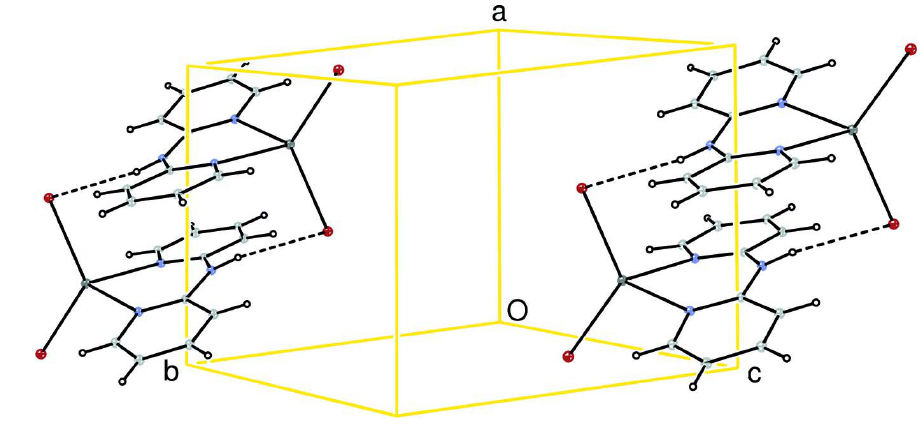
Figure 2 A partial packing diagram of the title